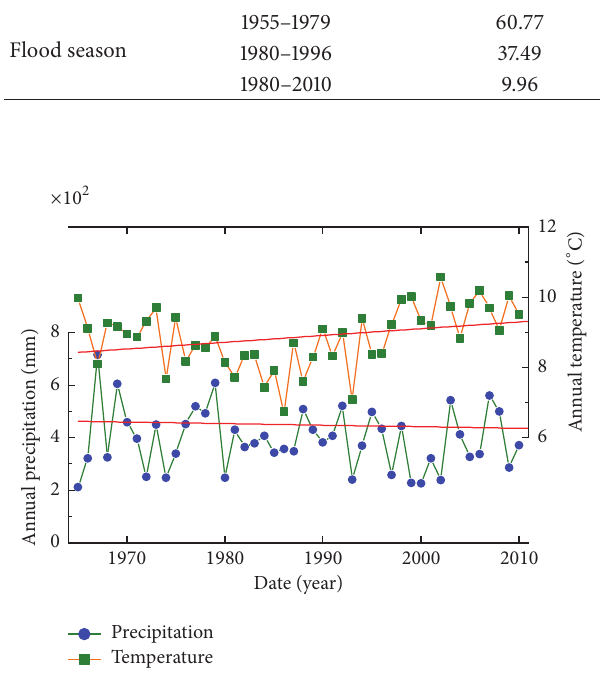
Figure 8: Trends in annual precipitation and temperature in the Huangfuchuan